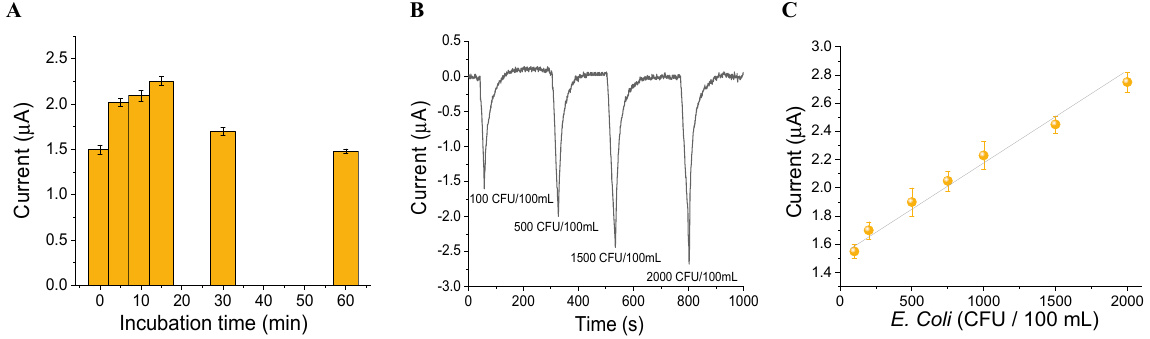
Figure 6. ( A ) Incubation time, ( B ) algal CB-SPEs amperogram after the addition of an increasing amount of E. coli, and ( C ) the corresponding calibration plot.